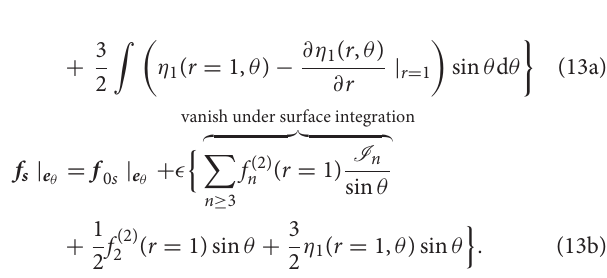
FIGURE 2 | Short summary of the decoupling of translational and rotational motion of the extended Stokes equations for an axisymmetric system. The velocity field of the fluid for translational motion of the particle U k e z is determined by { v r , v θ } and for rotational motion (cid:127) k e z is determined by v φ .